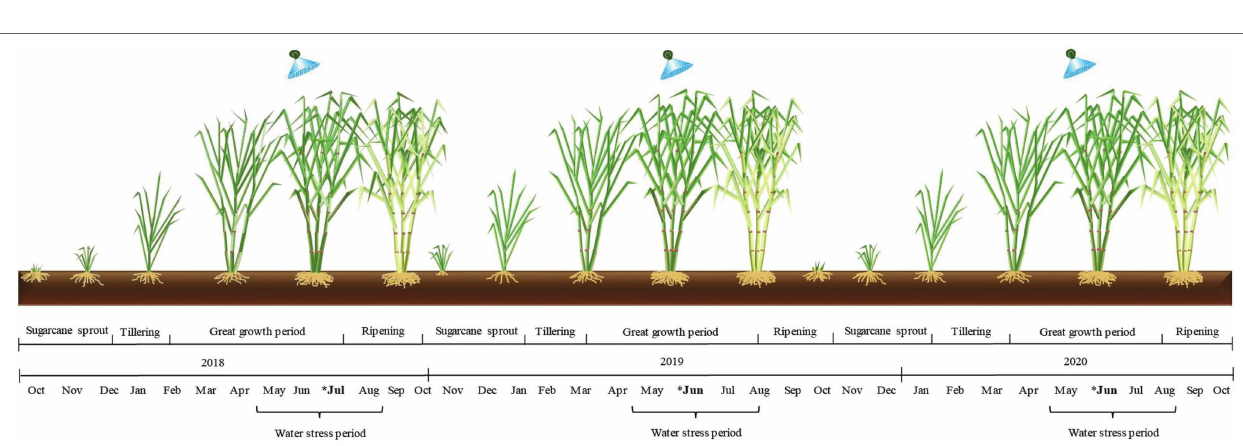
FIGURE 2 | Schematic experimental timeline with descriptions of the stages of the growing seasons and the timing of seaweed extract biostimulant application in each growing season